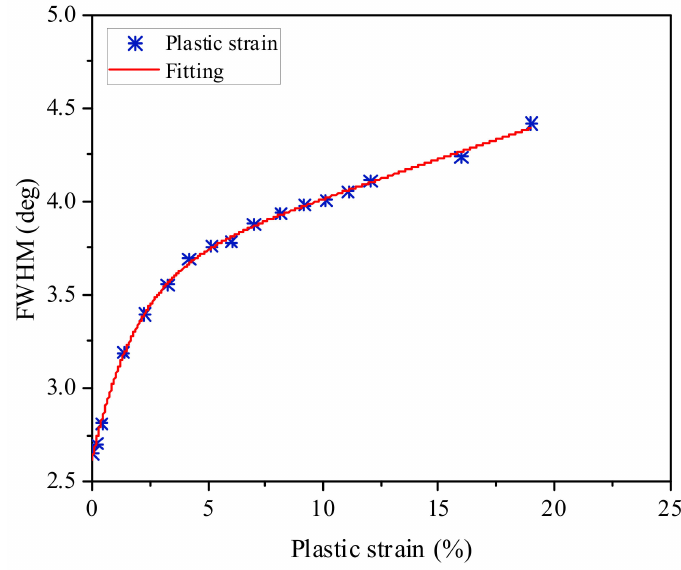
Figure 12. The relationship between full width at half the maximum ( FWHM ) and plastic strain.